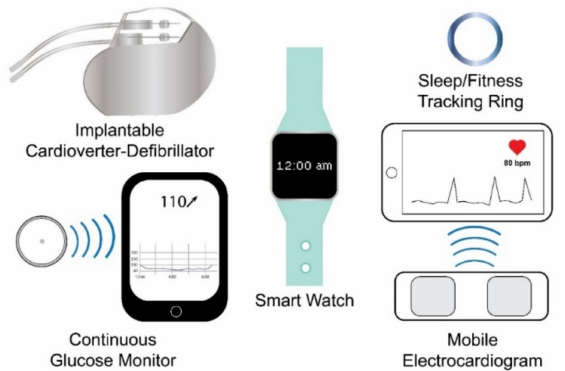
Figure 1. Examples of wearable sensing technologies. Wearable sensing technologies include internal (e.g., internal cardioverter-defibrillator and continuous glucose monitor) and external (e.g., smart watch, sleep/fitness tracking ring, and mobile electrocardiogram) wearable sensing